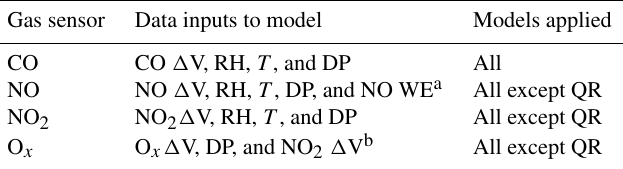
Table 1. Calibration modeling inputs for each gas sensor (CO, carbon monoxide; NO, nitrogen oxide; NO 2 , nitrogen dioxide; O x , oxi- dants) and model combination, where “all” indicates k -nearest neighbors ( k NN) hybrid, random forest (RF) hybrid, high-dimensional model representation (HDMR), multi-linear regression (MLR), and quadratic regression (QR). (cid:49) V is the voltage difference between the work- ing electrode (WE) voltage and the auxiliary electrode (AE) voltage measured by each electrochemical gas sensor. RH stands for relative humidity, T stands for temperature, and DP stands for dew point. Gas sensor Data inputs to model Models applied CO CO (cid:49) V, RH, T , and